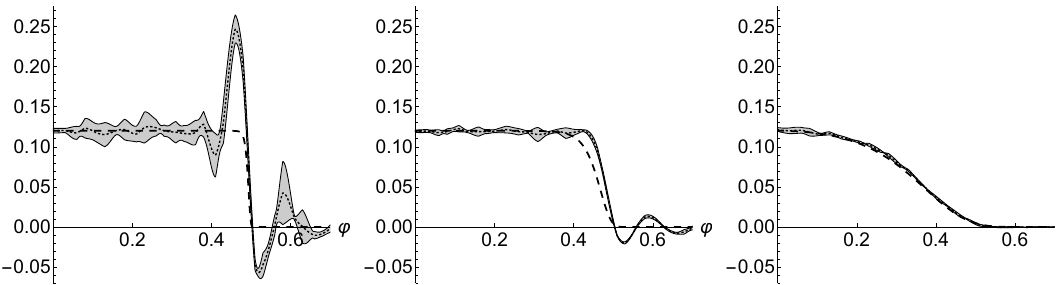
Figure 4 . Plots of I (cid:0) for a (cid:12)eld when (cid:14) 2 = 0, (cid:24) = 10, (cid:17) k = 0 : 1, for three cases: (cid:8) = 0 : 2, (cid:8) = 0 : 05 and (cid:8) = 0 : 01 respectively from left to right. The dashed line is the LCFA, the dotted line is the mean numerical result and the gray area marks out one standard deviation from the mean. The numerics were run (cid:12)ve times for each plot, and each numerical evaluation randomly allocated 1000 points in (cid:18) between 0 and 1, which were distributed with a cubic weighting towards (cid:18) =